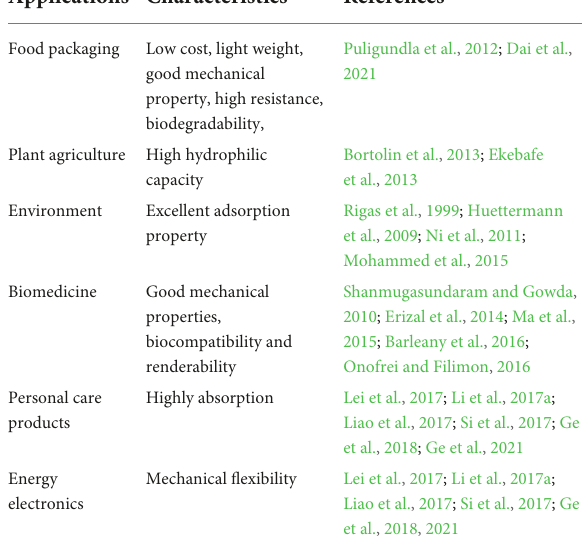
TABLE 3 Applications and characteristics of cellulose-based